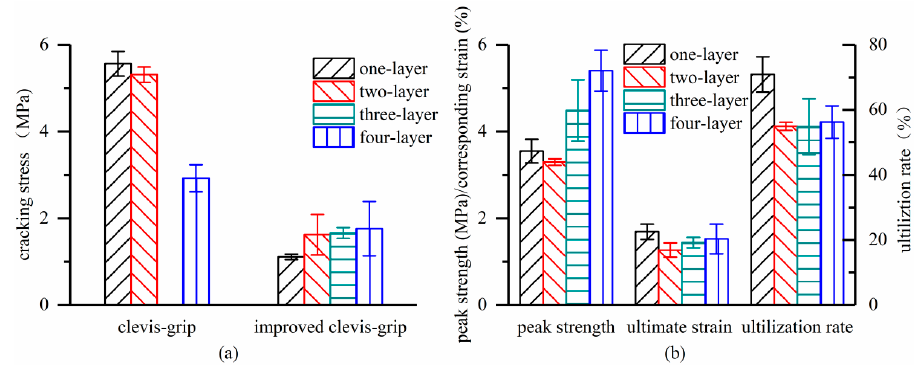
Figure 10. Effect of textile ratios on tensile behavior of TRC: ( a ) cracking stress; and ( b ) peak strength, ultimate strain, and textile utilization rate.